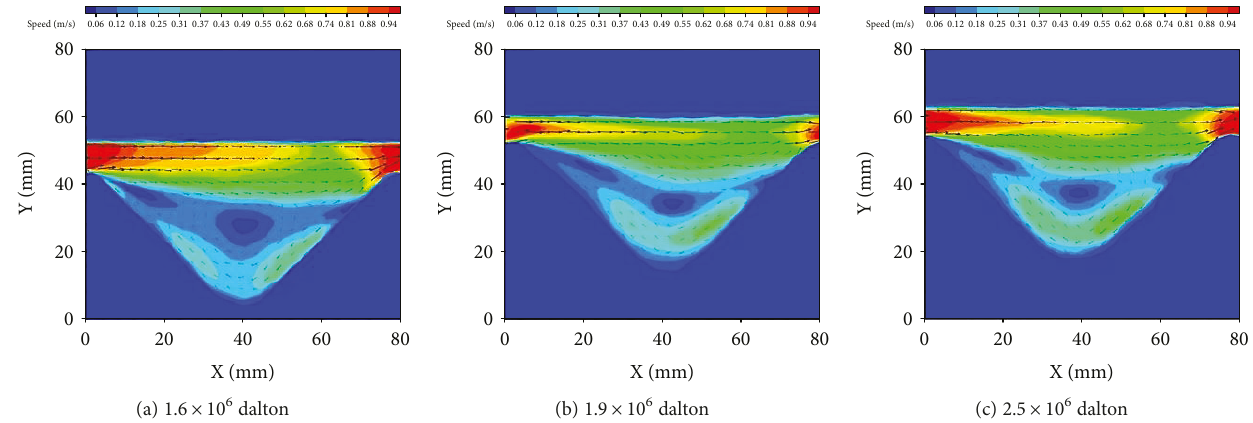
Figure 5: Velocity nephograms of di ff erent polymer molecular weight when fl owing through the partially pressured injection tool.